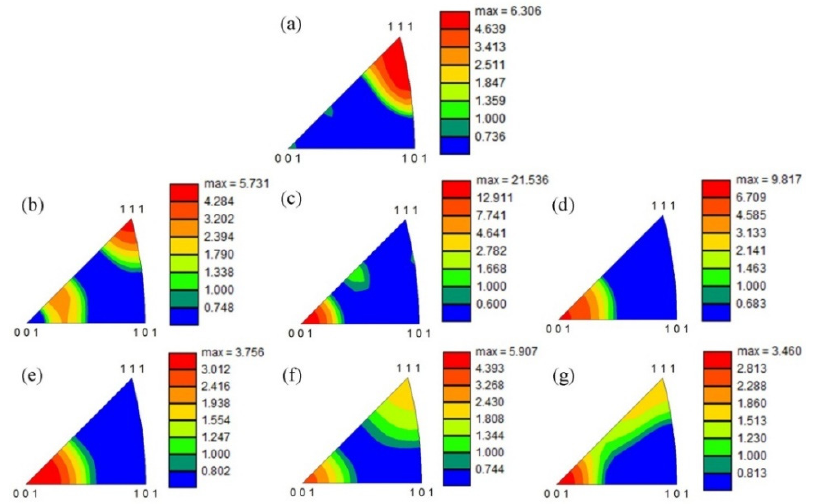
Figure 8. Inverse Pole Figure of B2 phase in normal direction (ND) of the spun workpiece formed at different passes: ( a ) initial welded tube, ( b ) pass 1st, ( c ) pass 2nd, ( d ) pass 3rd, ( e ) pass 4th, ( f ) pass 5th, ( g ) pass 6th.